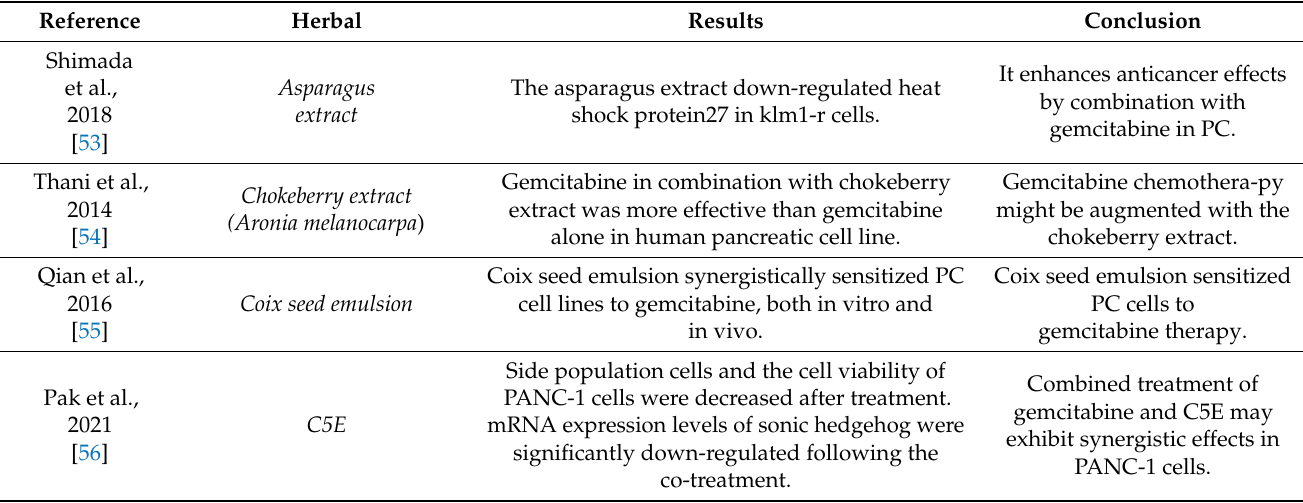
Table 1. Studies combining plants with chemotherapeutic agents (in alphabetical